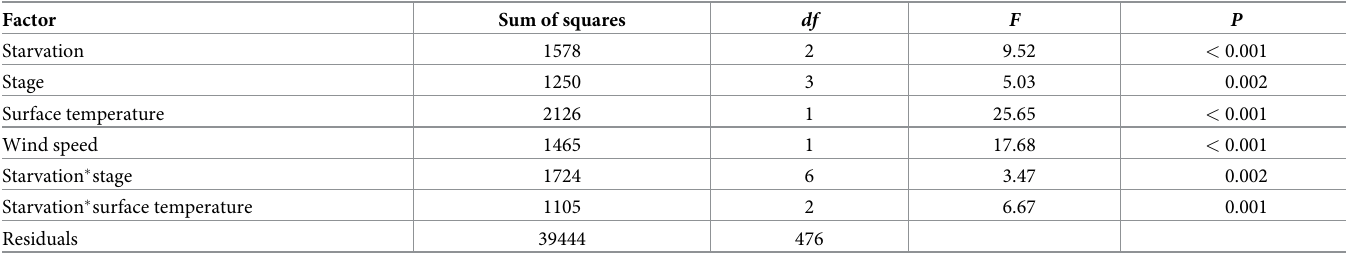
Table 2. Effect of starvation, stage, and environmental factors on total distance moved in the outdoor experiment.